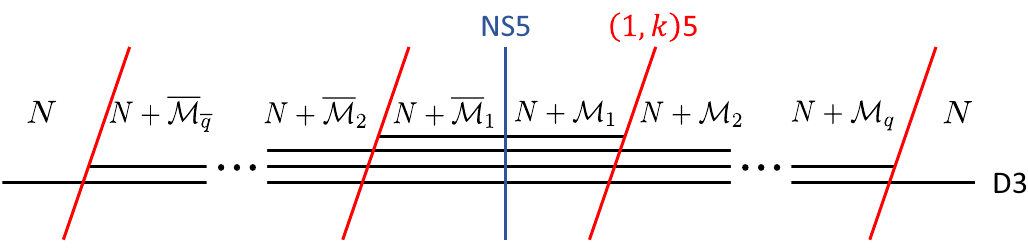
Figure 1 . The brane con(cid:12)gurations we consider in this paper. The blue line and the red lines represent an NS5-brane and (1 ; k )5-branes, respectively. The black lines represent coincident D3- branes, and each symbol above the D3-branes refers to the number of D3-branes on each